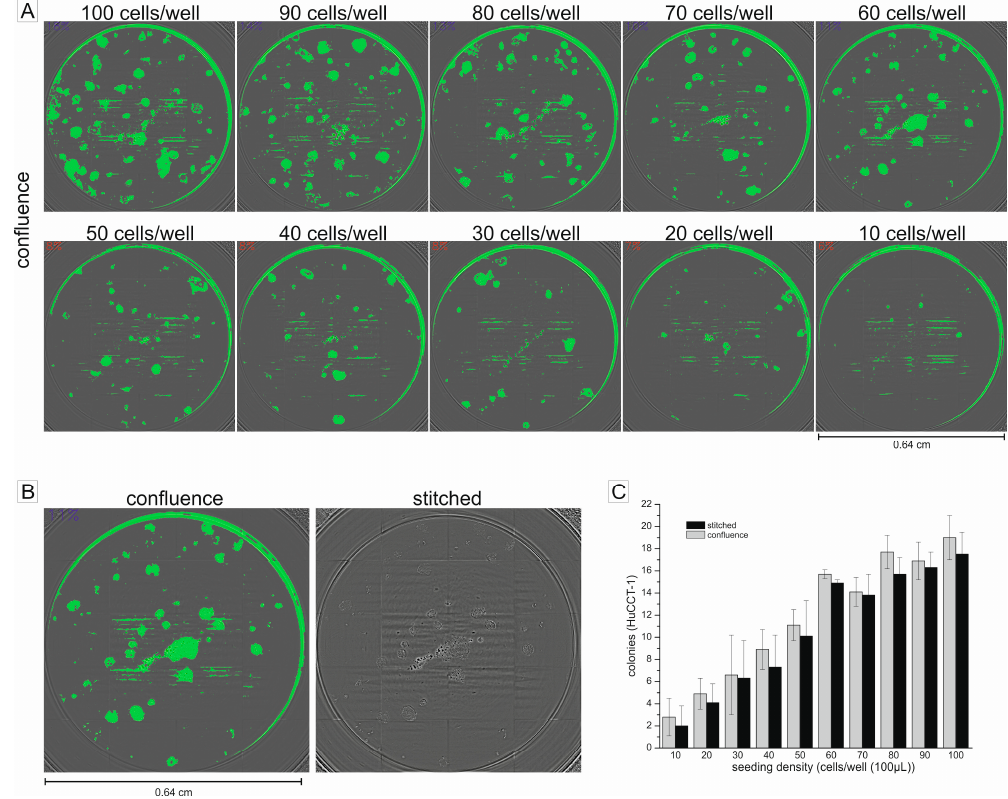
Figure 1. Establishment of cell seeding densities in 96-well microplates and comparison between confluence module detection and stitched pictures. ( A ) Exemplary series of different seeding densities in the 96-well microplate format (100 µL volume per well). Images were taken after 7 days using the confluence module. Green spots represent areas detected as confluent by the confluence module; ( B ) Enlarged exemplary picture pair showing the identical well pictured as a confluence detection photo and a stitched photo, respectively. For better visibility, contrast and brightness were adjusted in the stitched picture; ( C ) Quantification of the number of colonies after 7 days using different cell seeding densities ( n ≥ 3).